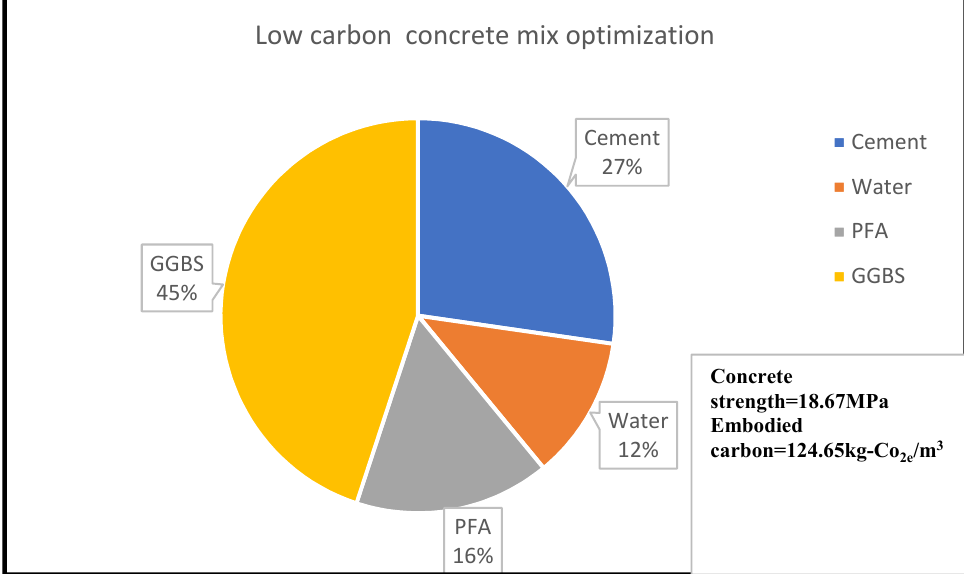
Figure 4. LCC constituent material at water content of 16% [22]. Table 12. Concrete mix optimisation extracted from Concrete Batch A [32].